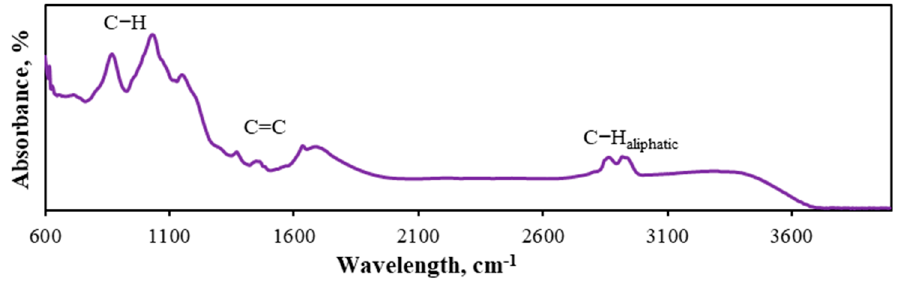
Figure 2. FTIR spectra of the investigated seaweed feedstock.